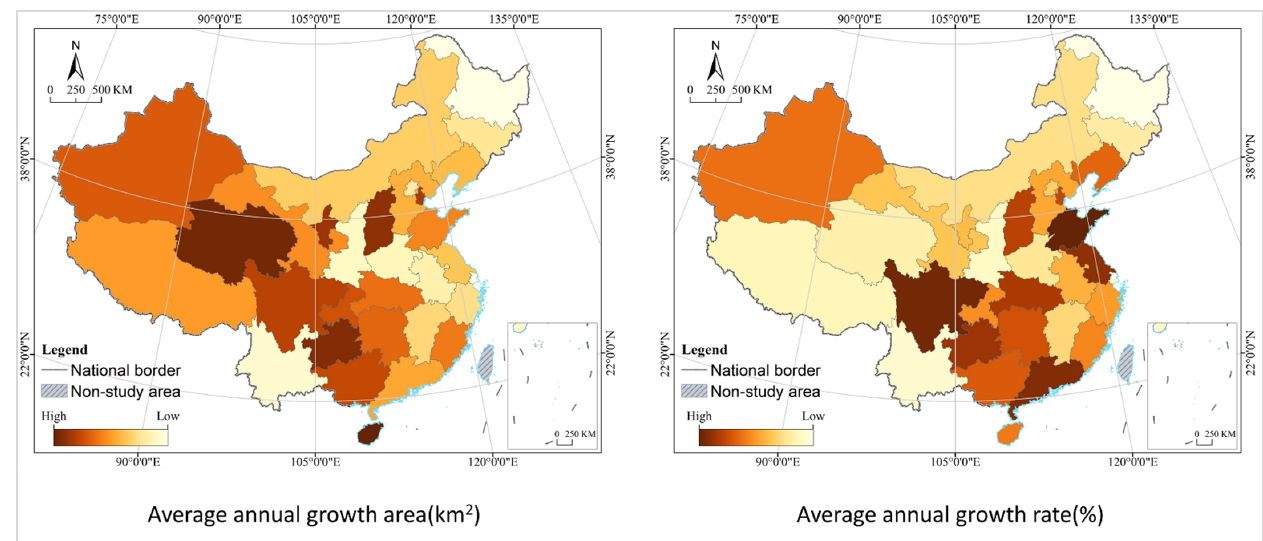
Figure 4. Comparative analysis on average annual growth of urban service-land.